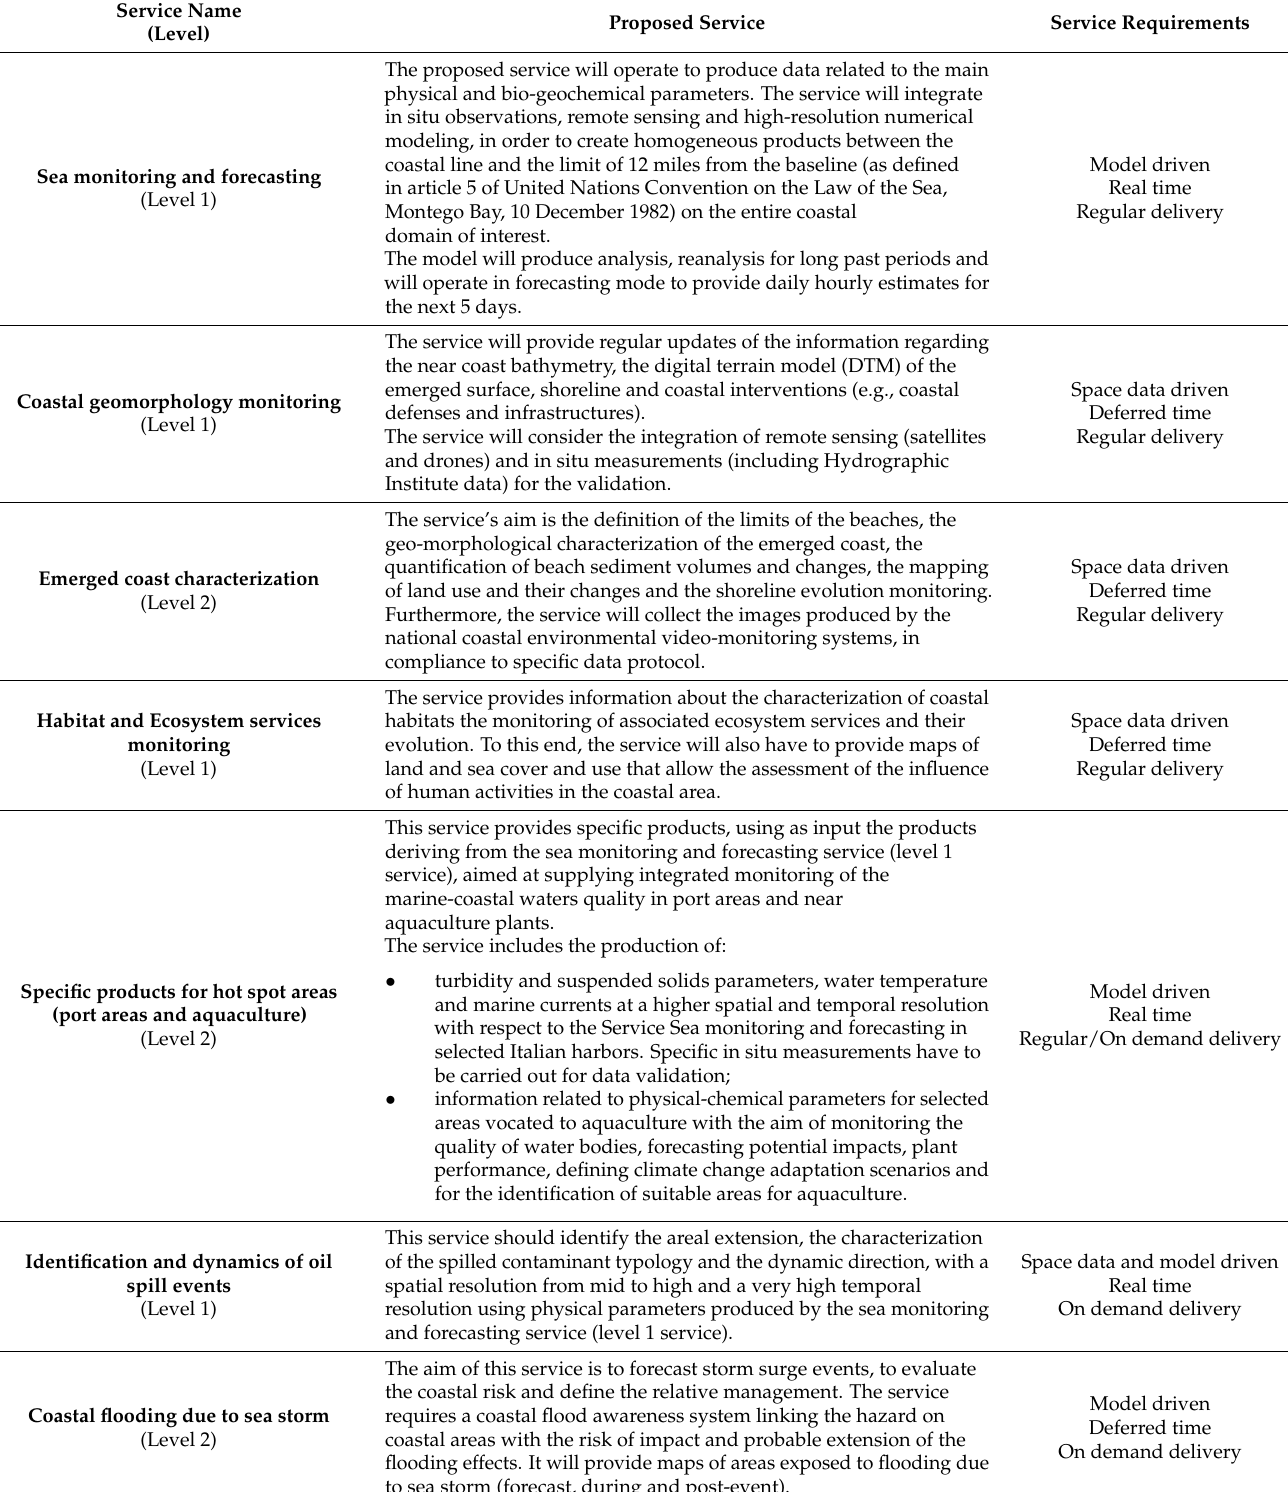
Table 5. The characteristics of the identified innovative national coastal services. The details of each product released by the Services are listed in Table